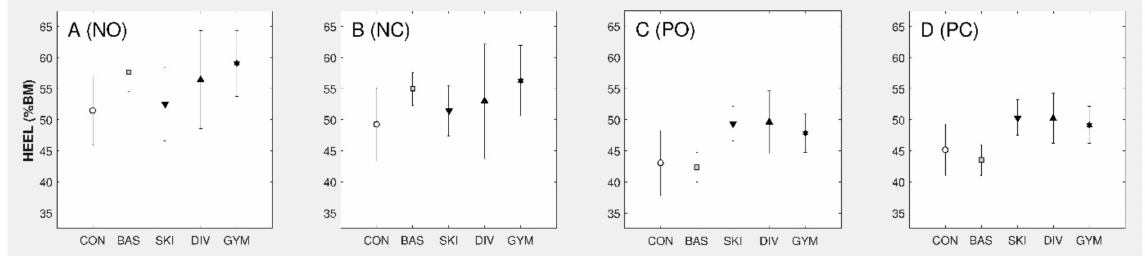
Figure 4. Anterior-posterior load distribution (HEEL) for different sports in positions in positions NO ( A ), NC ( B ), PO ( C ), and PC ( D ). CON—recreational athletes, BAS—Basketball, SKI—Ski Jumping, DIV—Diving, GYM—Gymnastics. Values are given as mean and standard